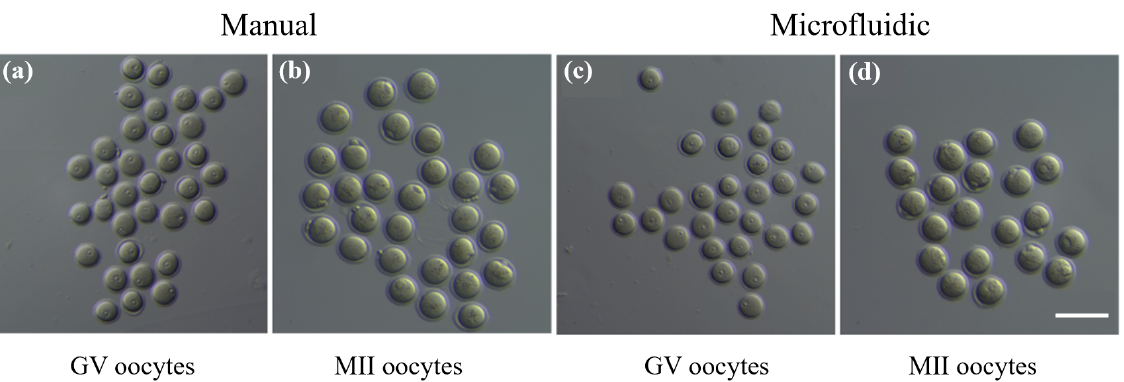
Figure 9. Evaluation of oocytes thawed from microfluidics vitrification via comparing with traditional manual vitrification method. ( a , c ) GV oocytes and ( b , d ) MII oocytes (with polar body extruded) were thawed from manual vitrification and microfluidics vitrification. Scale bar is 100 µ